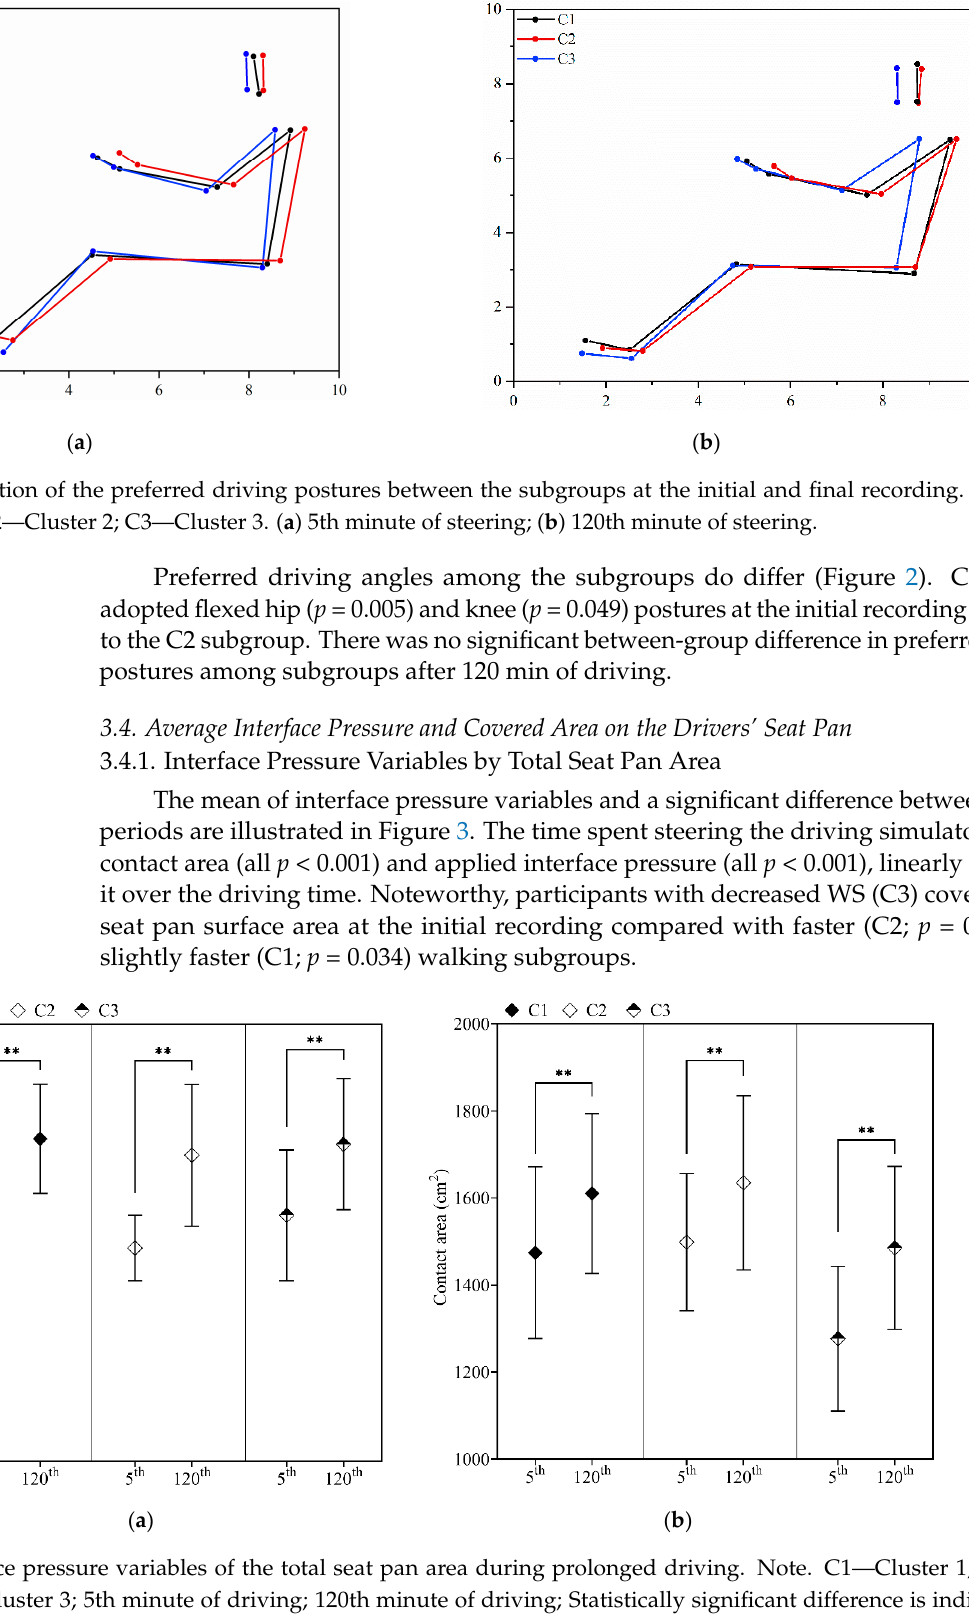
Figure 3. Interface pressure variables of the total seat pan area during prolonged driving. Note. C1—Cluster 1; C2—Cluster 2; C3—Cluster 3; 5th minute of driving; 120th minute of driving; Statistically significant difference is indicated as ** ( p < 0.001). ( a ) Average interface pressure in the minutes 5th and 120th; ( b ) Average contact area in the minutes 5th and 120th.